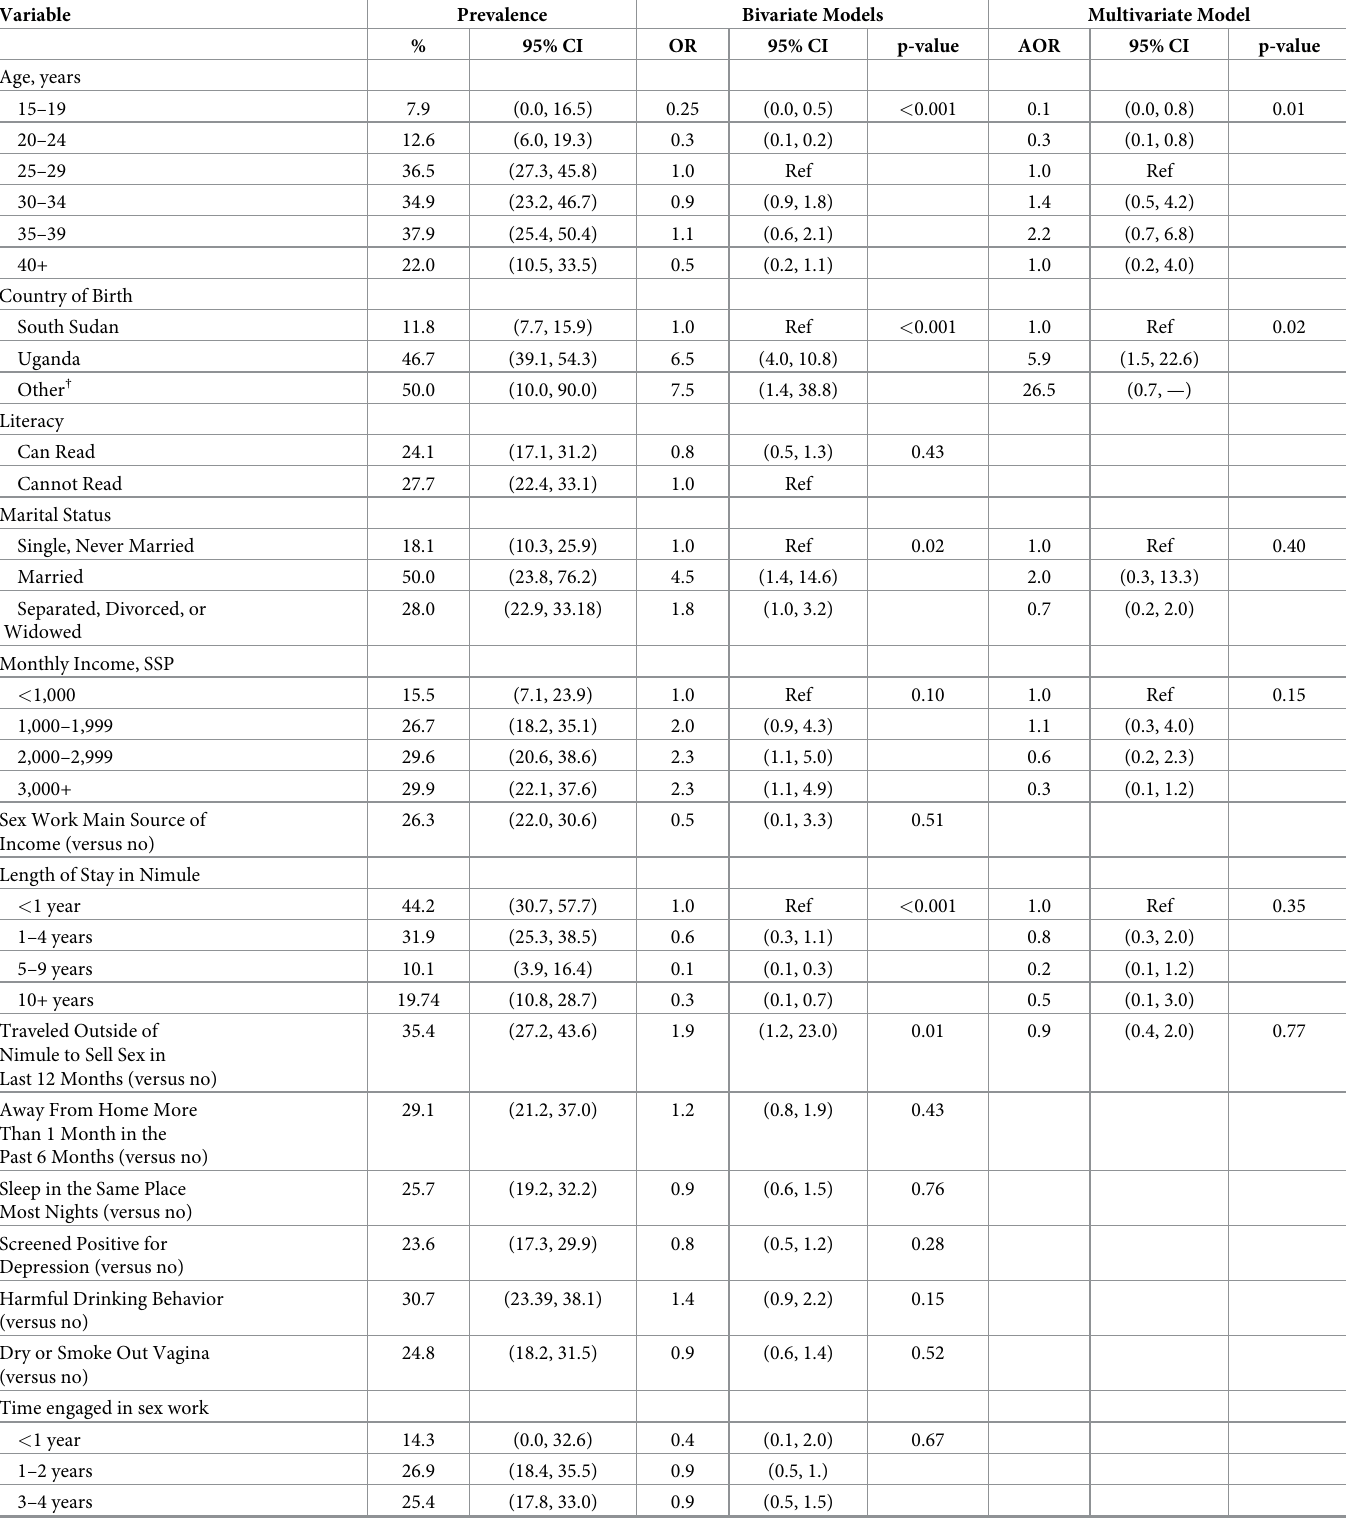
Table 3. Correlates of HIV infection among female sex workers /sexually exploited adolescents in Nimule, South Sudan, January-February 2017.